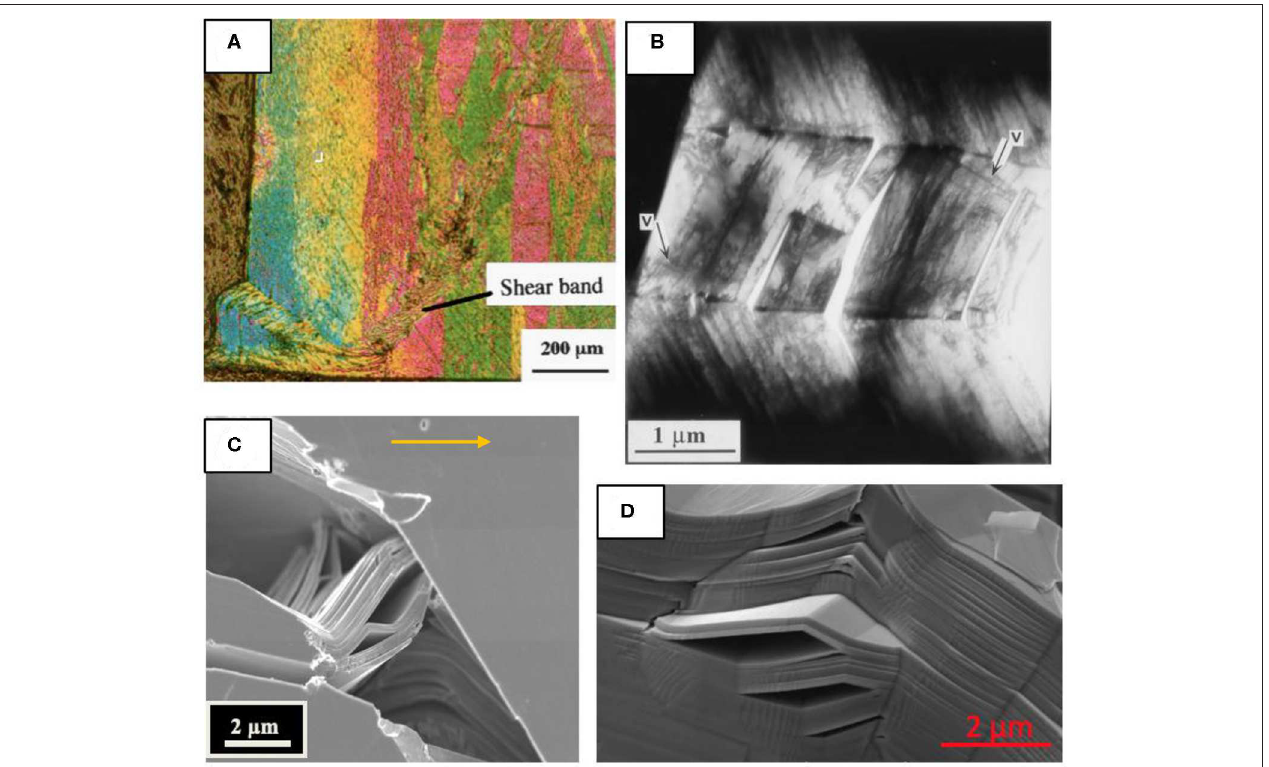
FIGURE 1 | Kink band, KB, formation in the MAX phase Ti 3 SiC 2 at various scales. (A) Kink band formed at edge a 2mm cube wherein the basal planes were highly oriented vertically ( Barsoum and El-Raghy, 1999). (B) KB in TEM, (Barsoum et al., 1999). (C) Field-emission scanning electron microscope, SEM, image of a bridged crack in a coarse-grained Ti 3 SiC 2 microstructure (Gilbert et al., 2000). Heavily deformed lamella bridge the crack and significant amounts of delamination and bending/kinking are observed. Such processes are highly unusual in ceramic systems and account for the high plateau fracture toughness values measured. Arrow indicates direction of crack propagation. (D) KBs and concomitant delaminations of a solid bridge between pores ( Sun et al., 2005) (A,B) reproduced with permission from Metallurgical and Materials Transactions A, Springer Nature. (C,D) Reproduced with permission from Scripta and Acta Materialia,